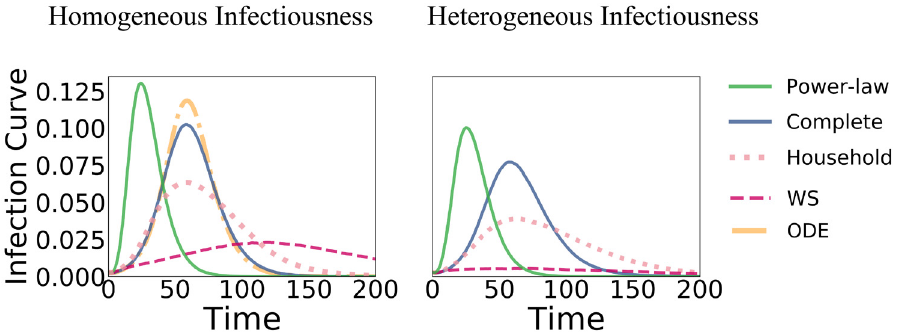
Fig 6. Fraction of nodes in I 1 ( y -axis) over time Left: Fixed infection rate λ . Right : Node-based infection rate λ drawn from an exponential distribution. Note the large difference between the two evolutions on the Watts–Strogatz (WS)